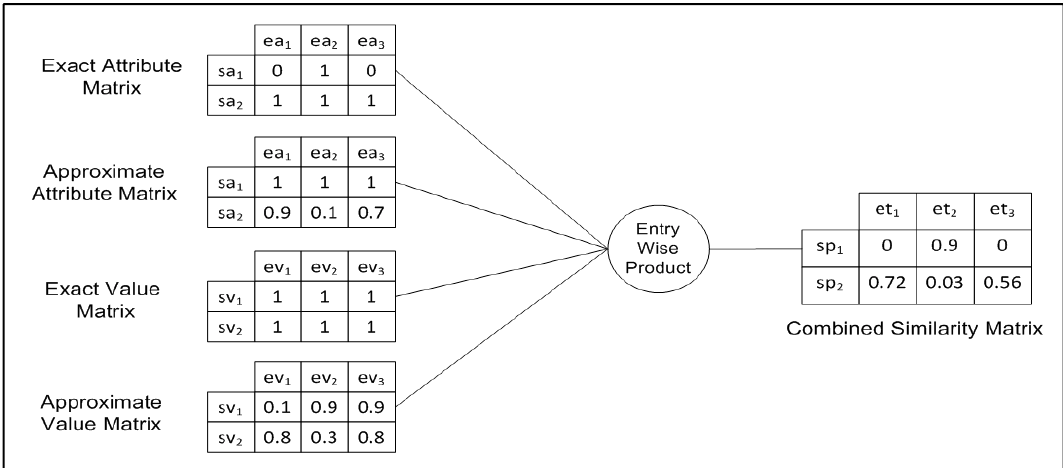
Figure 3. Exact and approximate entry-wise products.